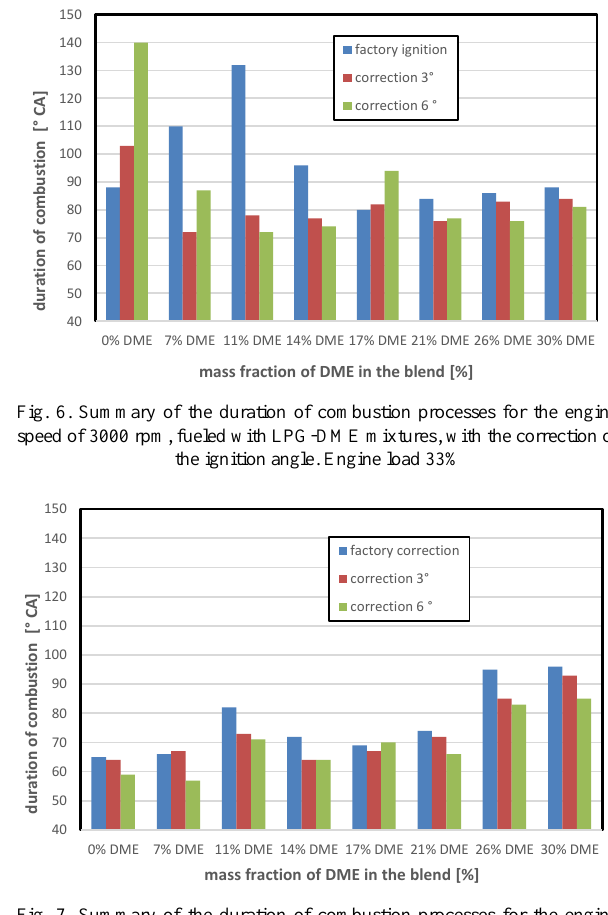
Fig. 7. Summary of the duration of combustion processes for the engine speed of 3000 rpm, fueled with LPG-DME mixtures, with the correction of the ignition angle. Engine load